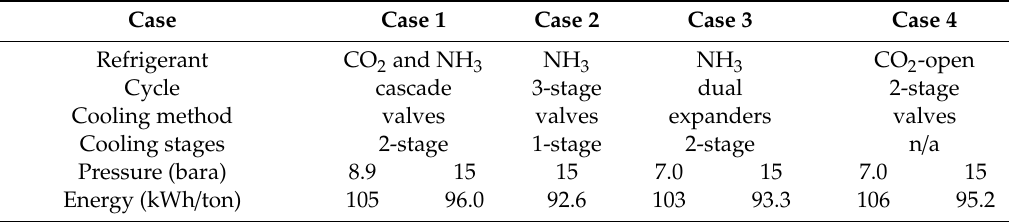
Table 3. Summary of optimized power consumption for the base process schemes.